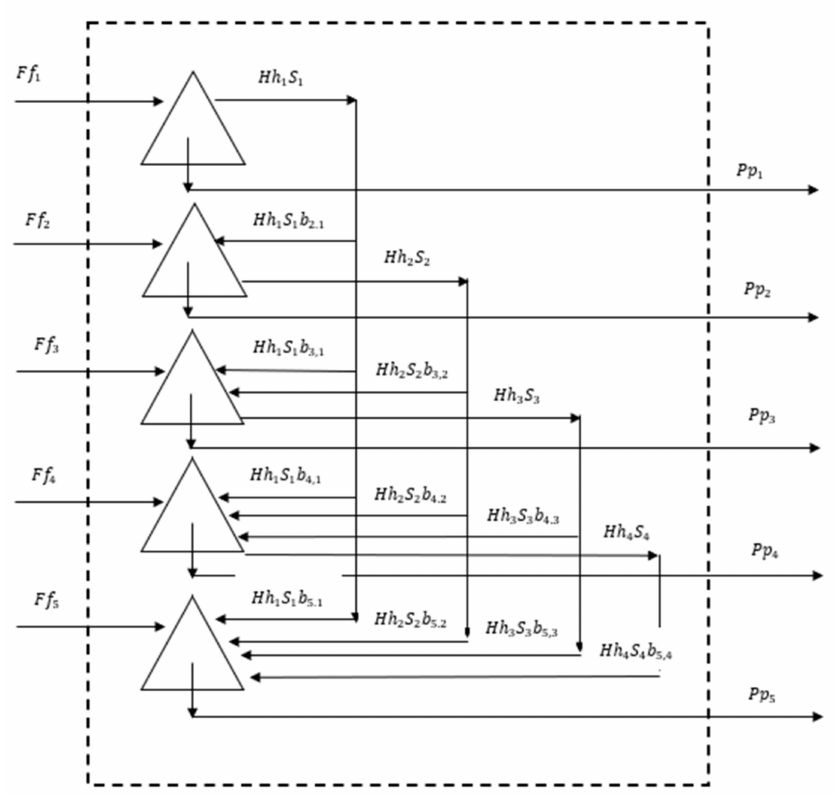
Figure 1. The classic size-mass balance model. The model depicts a perfectly mixed mill region, represented by the dotted line, with each size range within the region represented as a triangle. The arrows represent the contributions from a feed stream and to a product stream and the internal flows from and to each size